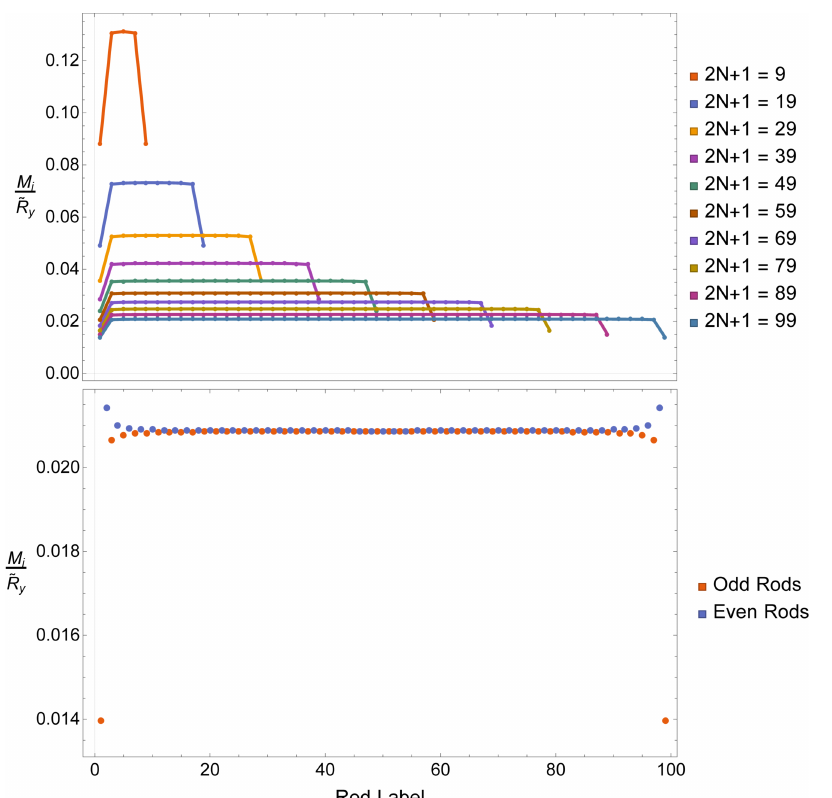
, for different total numbers of 2 i − 1